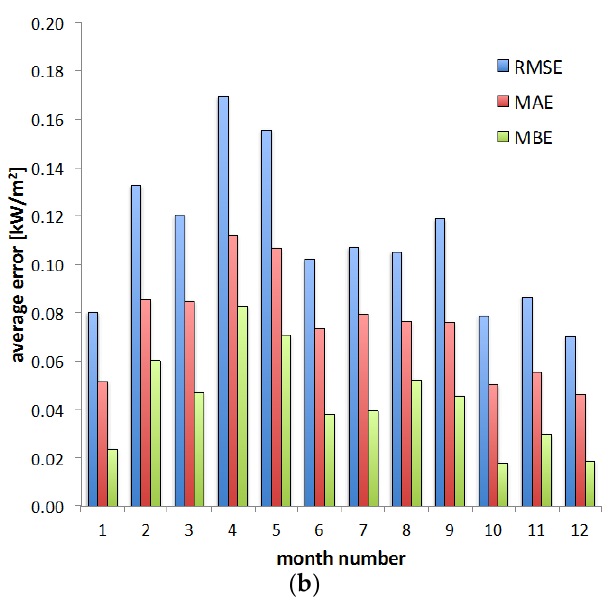
Figure 6. Monthly average values of the daily RMSE, MAE and MBE obtained from the 1-day ahead estimates at the two sites. ( a ) Site “Gi”; ( b ) Site “Ma”.